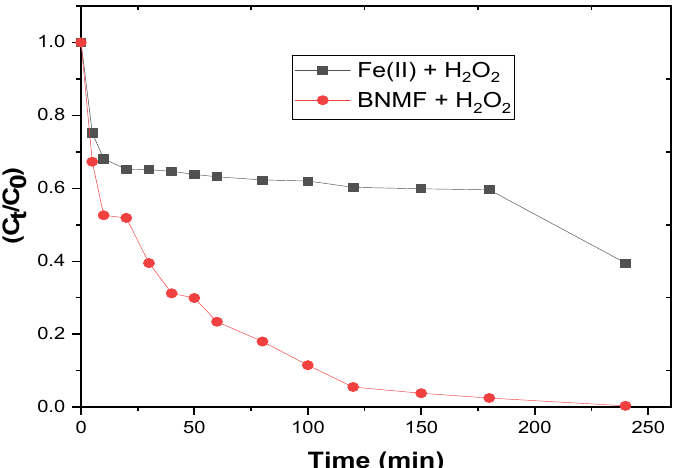
Figure 5. Influence of the presence of BNMF on the degradation of indigo carmine in comparison with the results obtained using Fe(II) in an oxygenated medium as